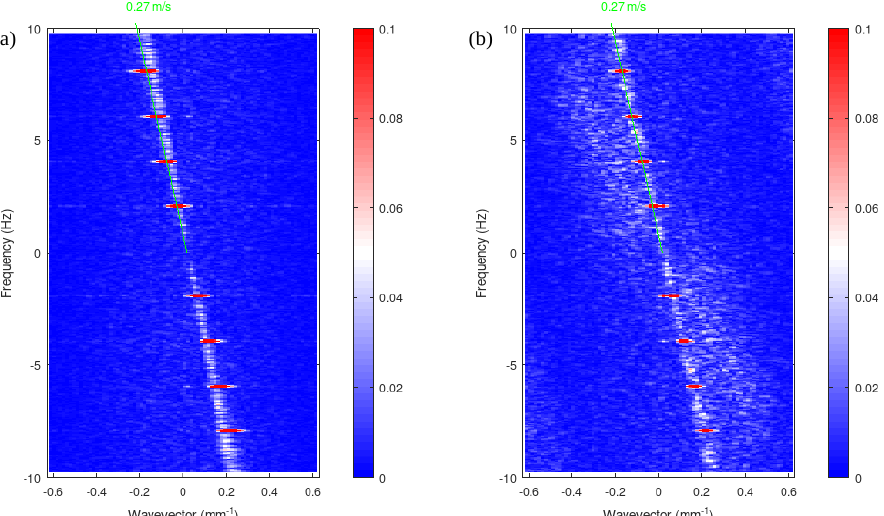
Figure 5. Close-ups of the dispersion maps presented in Figure 4. The linear fits of the dispersion bands and the corresponding wave velocities are shown ( a , b